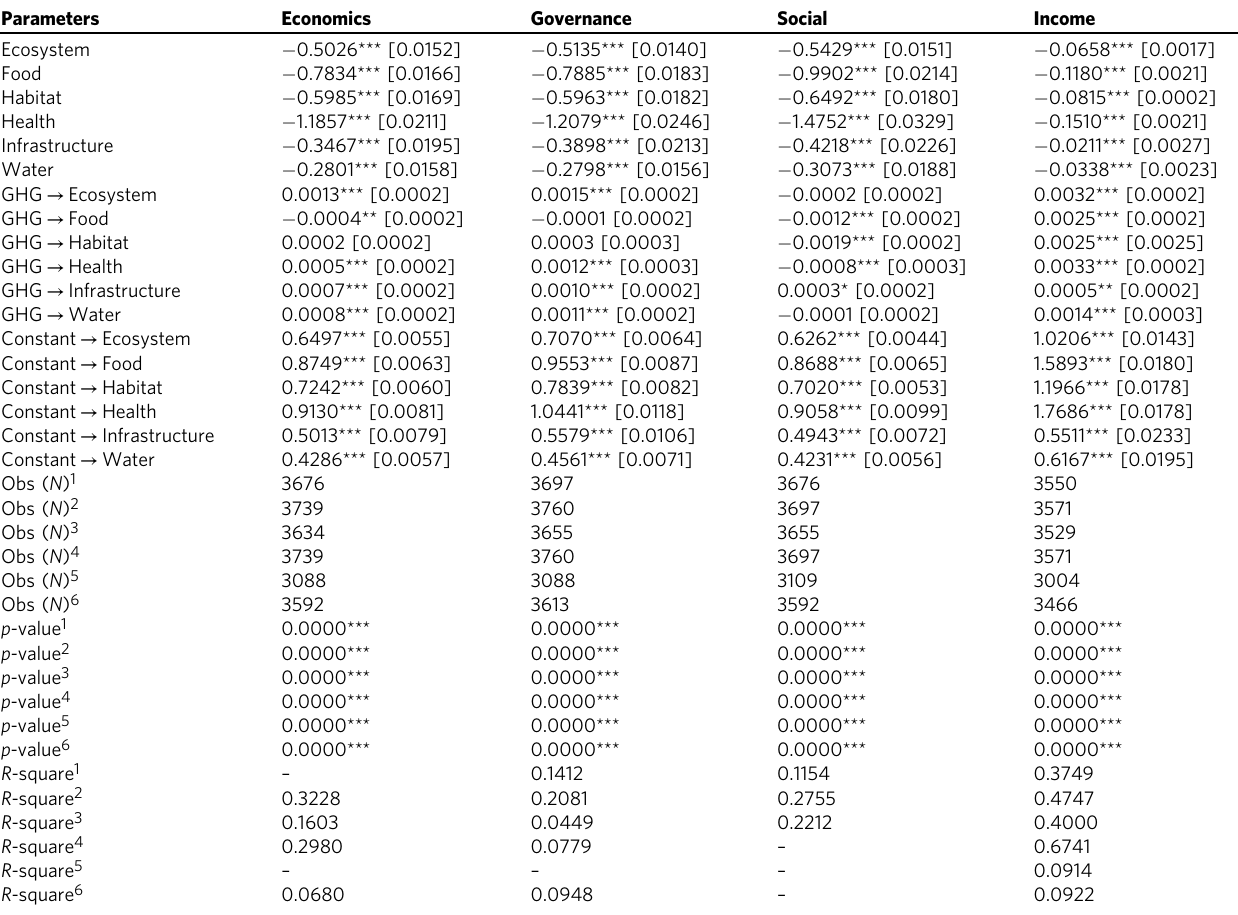
Table 1 Parameter